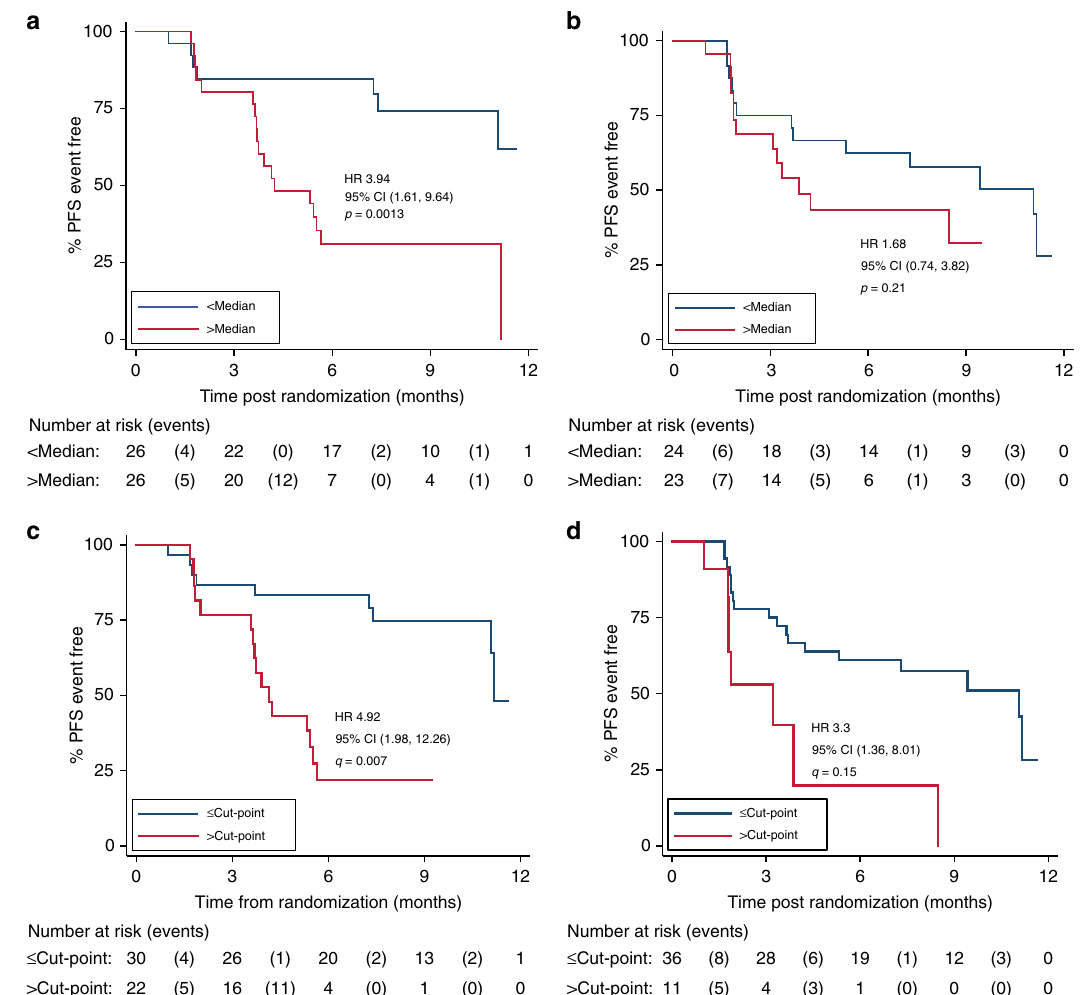
Fig. 3 Early PIK3CA ctDNA dynamics predict progression-free survival (PFS) on palbociclib and fulvestrant more strongly than ESR1 dynamics. a Kaplan – Meier plot for PFS of patients randomized to palbociclib and fulvestrant split by median PIK3CA CDR 15 . b Kaplan – Meier plot for PFS of patients randomized to palbociclib and fulvestrant split by median ESR1 CDR 15 . c Kaplan – Meier plot for PFS of patients receiving palbociclib and fulvestrant split by high or low PIK3CA CDR 15 using an optimized cut-off calculated with Harrell ’ s c-index. q value log-rank test corrected for false discovery with Benjamini – Hochberg. d Kaplan – Meier plot for PFS of patients receiving palbociclib and fulvestrant split by high or low ESR1 CDR 15 using an optimized cut- off calculated with Harrell ’ s c-index. q value log-rank test corrected for false discovery with Benjamini – level of detection (Supplementary Table 1). Baseline mutant